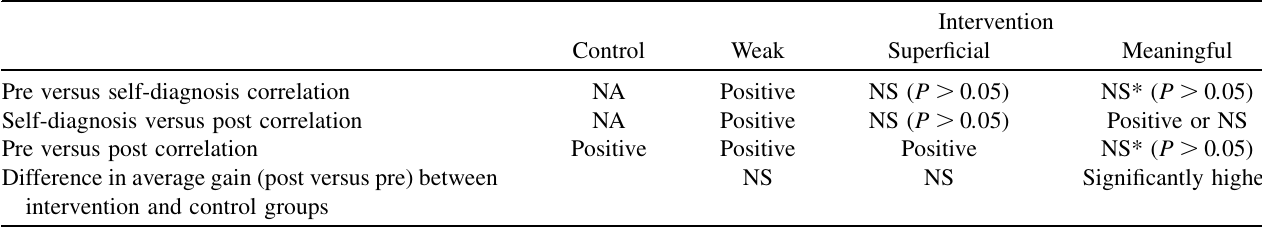
TABLE VI. Expected correlations within groups regarding the physics principles aspect of the physics section of the rubric (NA indicates an item being not applicable; NS, nonsignificant difference; NS*, nonsignificant difference due to low achievers reducing the gap between themselves and high achievers).